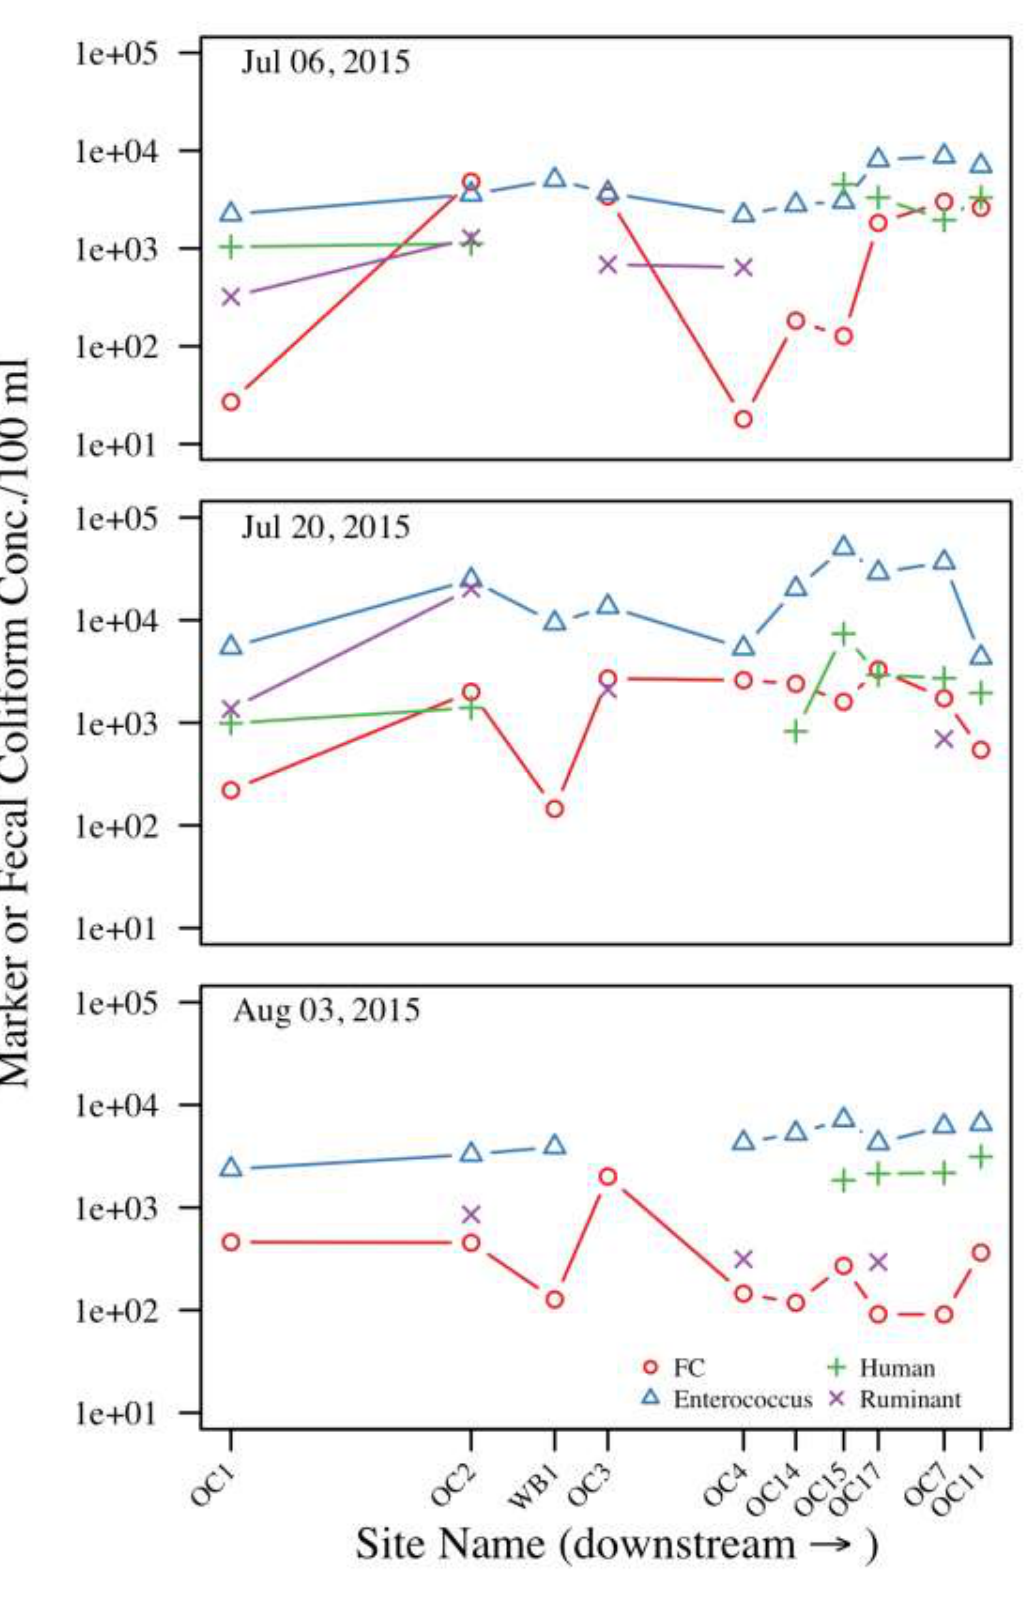
Figure 2. Fecal indicator and molecular marker concentrations during the study period. Symbols indicate MST marker concentrations while segments connect adjacent sites with detectable values of the same marker.